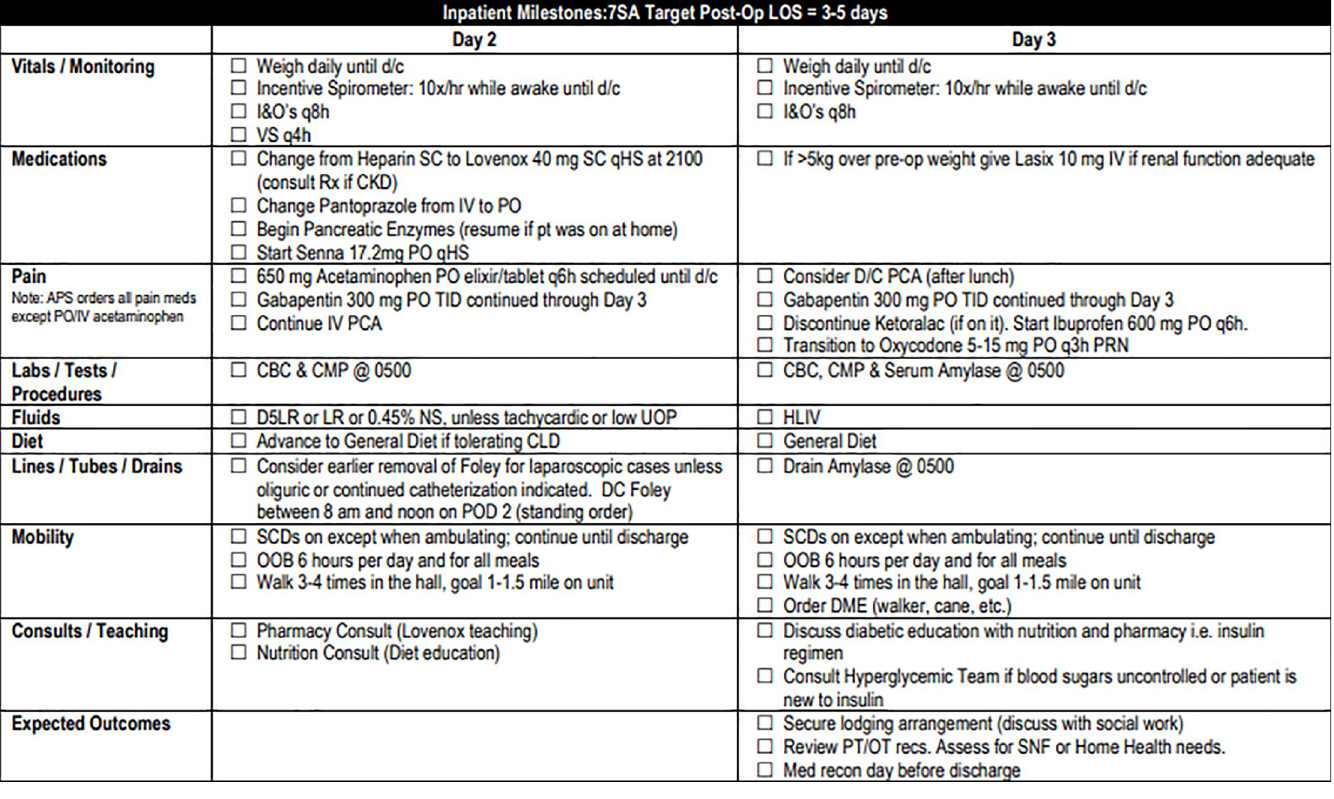
Fig 4. Whipple Post-operative Pathway Days